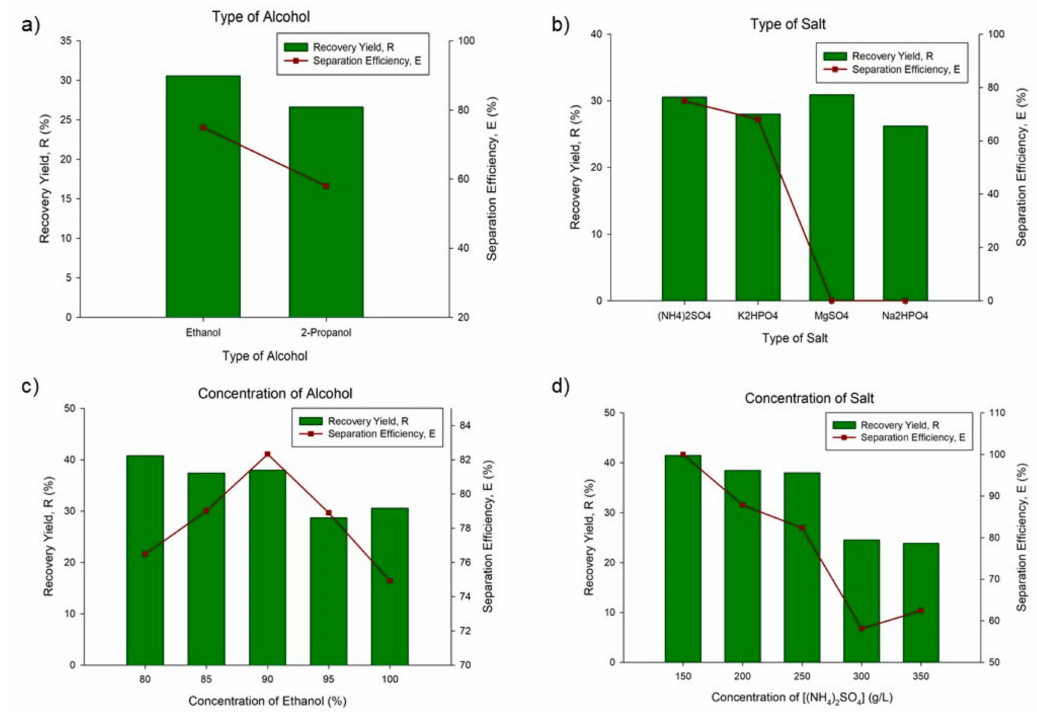
Figure 2. E ff ect of di ff erent conditions on the protein recovery and separation e ffi ciency: ( a ) E ff ect of the alcohol type, ( b ) E ff ect of the types of salt, ( c ) E ff ect of the ethanol concentration, and ( d ) E ff ect of the ammonium salt